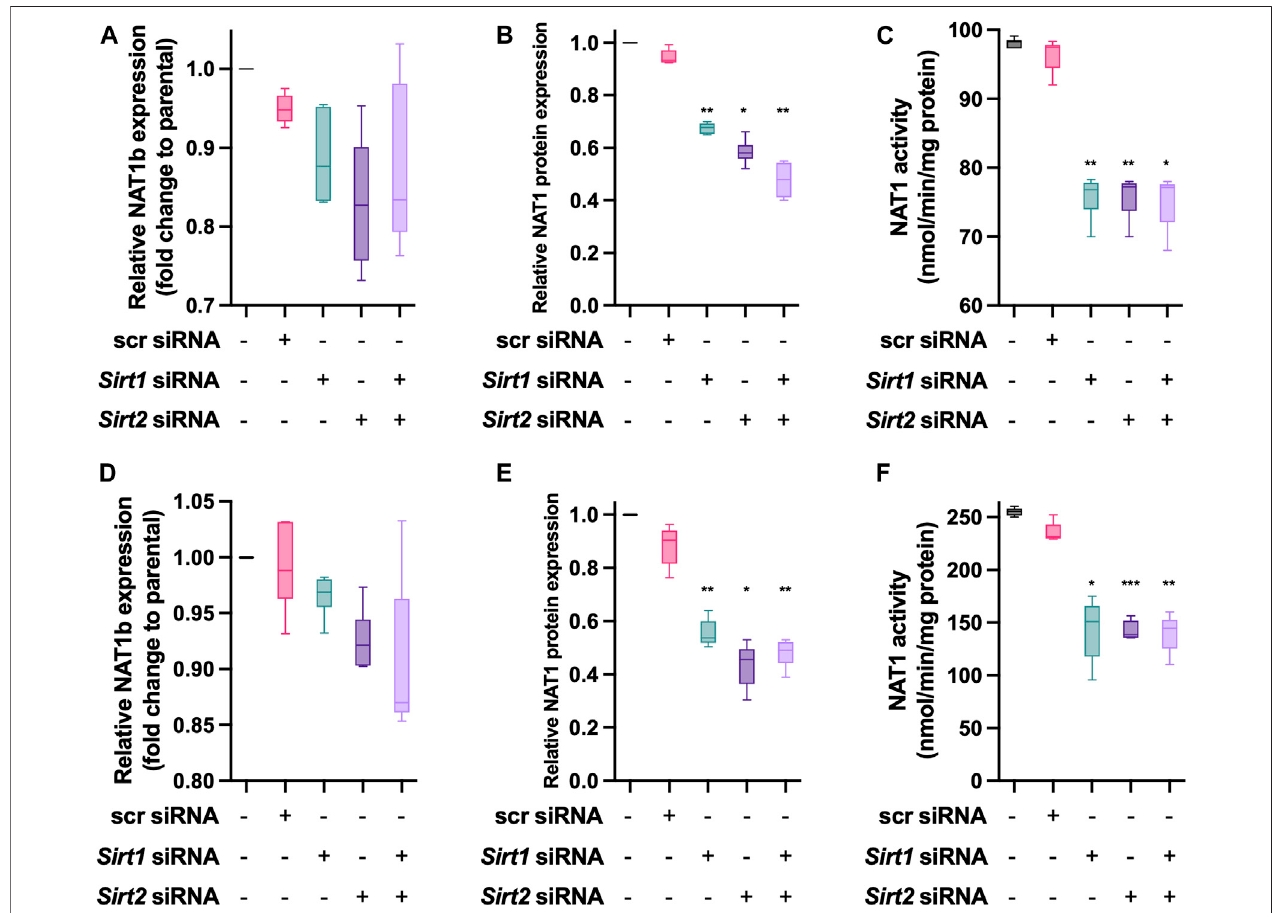
FIGURE 5 | Effect of Sirt1 and Sirt2 KD on NAT1 expression and activity in MDA-MB-231 and ZR-75 - 1 breast cancer cells. MDA-MB-231 cells were transfected with Sirt1 and Sirt2 siRNAs for 72-h, then (A) NAT1b transcript. (B) NAT1 protein expression and (C) NAT1catalytic activity was quanti fi ed. ZR-75-1 cells were transfectedwith Sirt1 and Sirt2 siRNAsfor72-h,then (D) NAT1btranscript (E) NAT1protein expressionand (F) NAT1 catalytic activitywasquanti fi ed.Dataispresented as the mean ± SEM of four independent experiments. *, p < 0.05; **, p < 0.01 compared vs. scramble control.